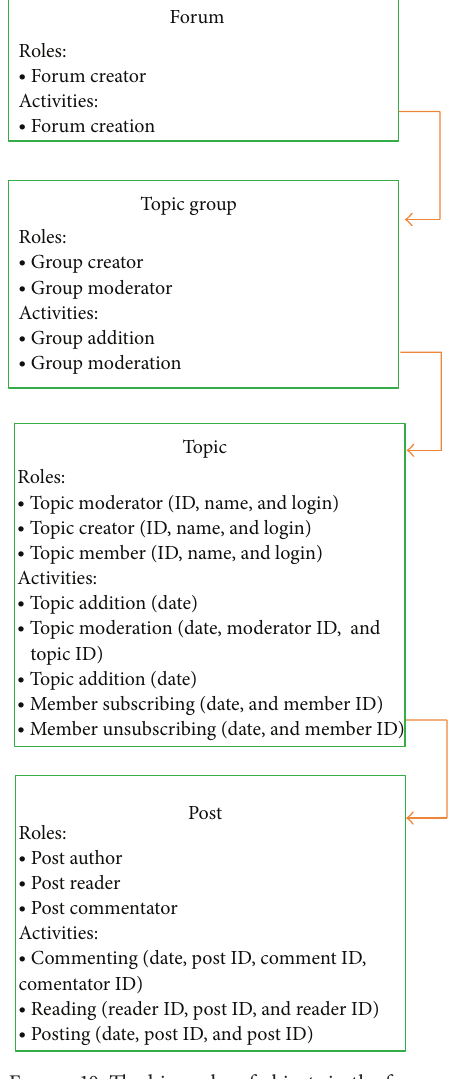
Figure 10: The hierarchy of objects in the